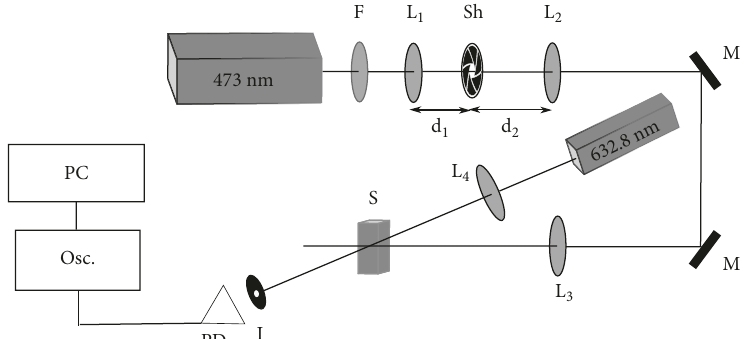
Figure 4: Sketch of the mode-mismatched dual-beam thermal lens technique: lens (L), mirror (M), sample (S), shutter (Sh), iris (I), IR filter (F), and photodetector (PD). 𝑑 𝑖 (𝑖 = 1,2) represents the focal distance.